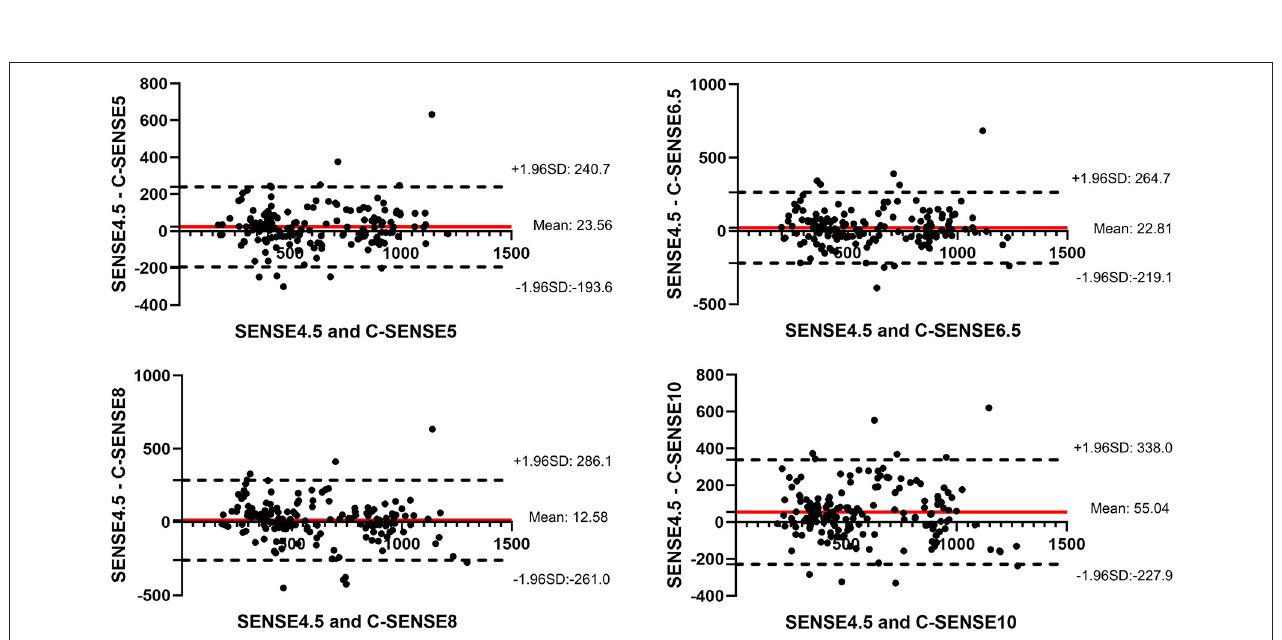
FIGURE 3 | Bland–Altman plots together with 95% CI of arterial transmit time measurements from all ROIs in all volunteers.